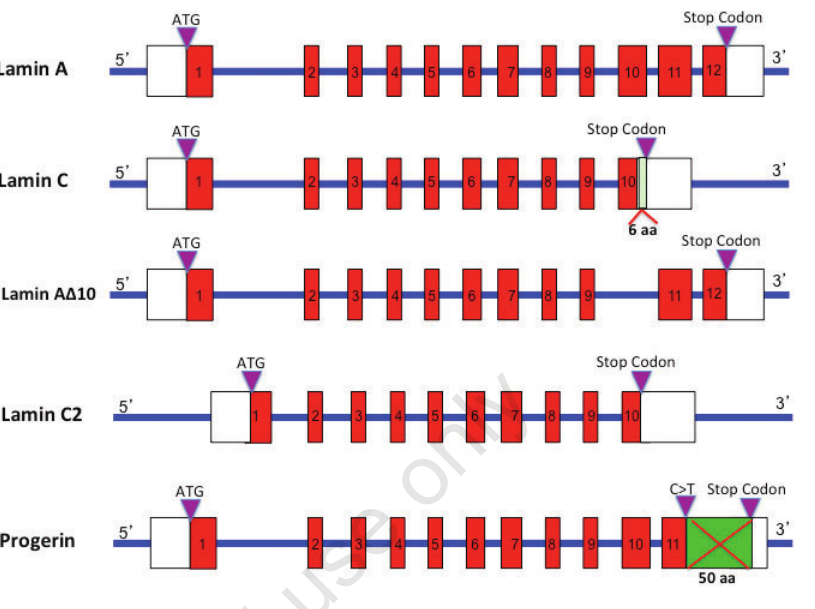
Figure 1. Alternative splicing of LMNA: LMNA has 12 exons. A C>T transition in exon 10 is responsible for the alternating splicing and generation of short form (Lamin C) or long form (Lamin A) isoforms. Lamin C has 6 novel amino acids at the C-terminus domain and is 572 aa long, while Lamin A is a 646 aa protein. Lamin A Δ10 isoform skips exon 10 completely, while Lamin C2 utilizes an alternative initiation codon in intron 1. Progerin, responsible for Hutchinson-Gilford Progeria Syndrome results from a synony- mous change in exon 11 that leads to deletion of 50 amino acids but retention of the CAAX box at the